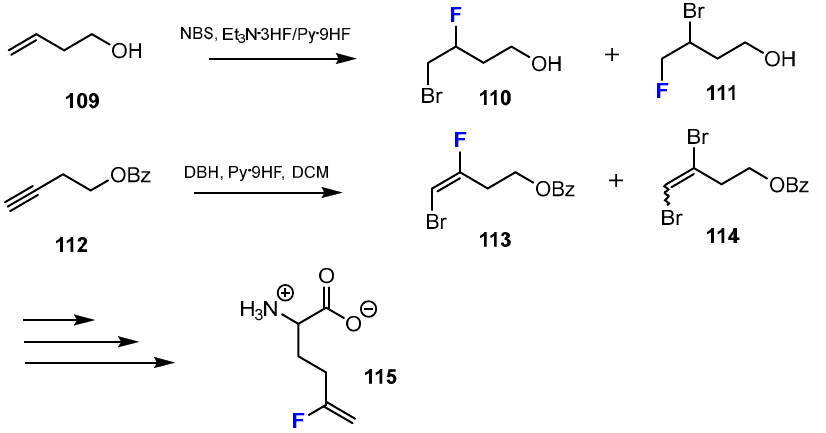
Scheme 28. Fluorination in the synthetic pathway of fluorinated short-chain fatty acids via bromoflu- orination by Lübke et al.